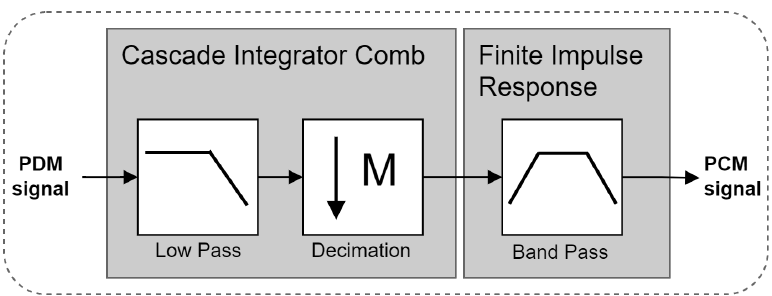
Figure 5. Block diagram of the conversion of PDM to PCM